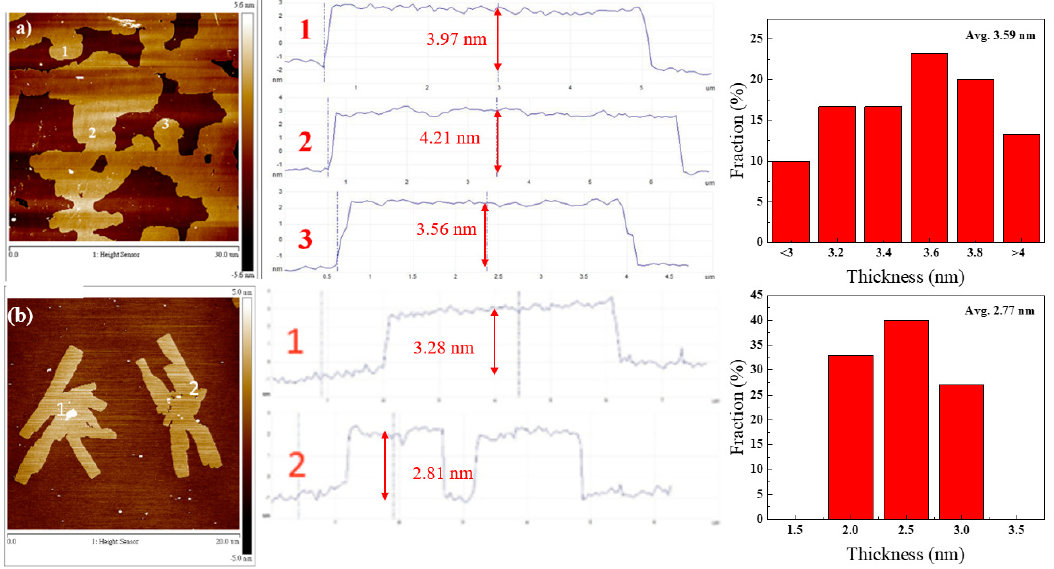
Figure 3. AFM images of different graphene sheet sizes and distribution of thickness of ( a ) GN-13 and ( b ) GN-28 with 30 samples.